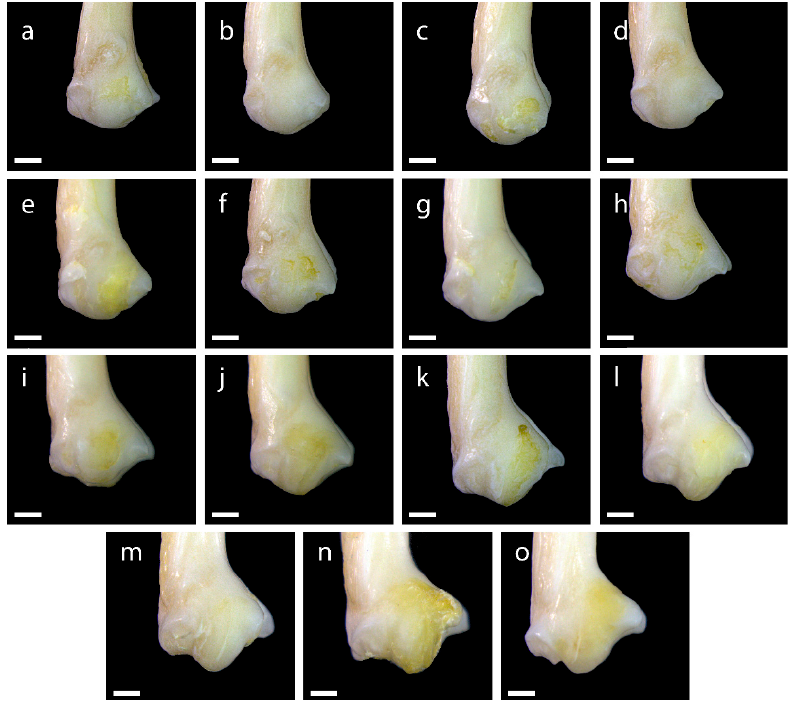
Figure A14. Microscopic images of the lateral left view of the pinnules of P. bichir PO5. The images ( a – o ) correspond to the 1st, 2nd, 3rd, 4th, 5th, 6th, 7th, 8th, 9th, 10th, 11th, 12th, 13th, 14th, and 15th pinnules, respectively. Scale = 1 mm.